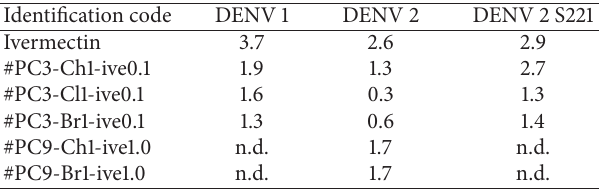
Table 3: Half maximal effective concentration (EC 50 ) expressed in 𝜇 M for ivermectin and ivermectin-loaded liposomal formulations. Identification